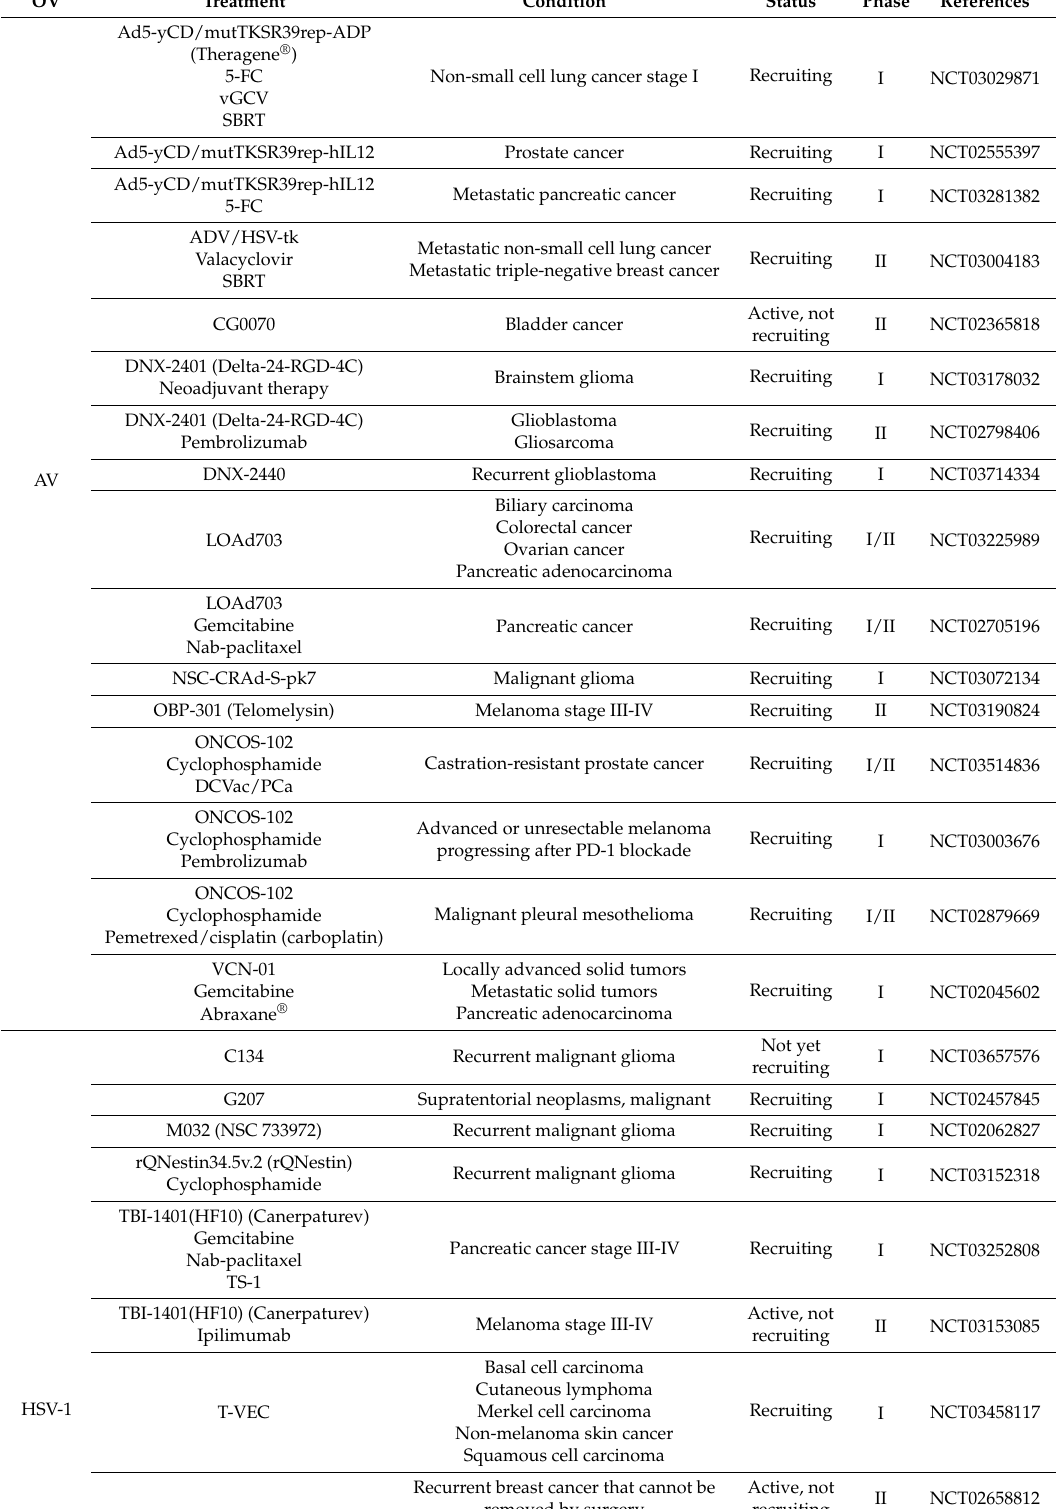
Table 1. Oncolytic DNA and RNA viruses in clinical trials. A selected list includes viruses described in the